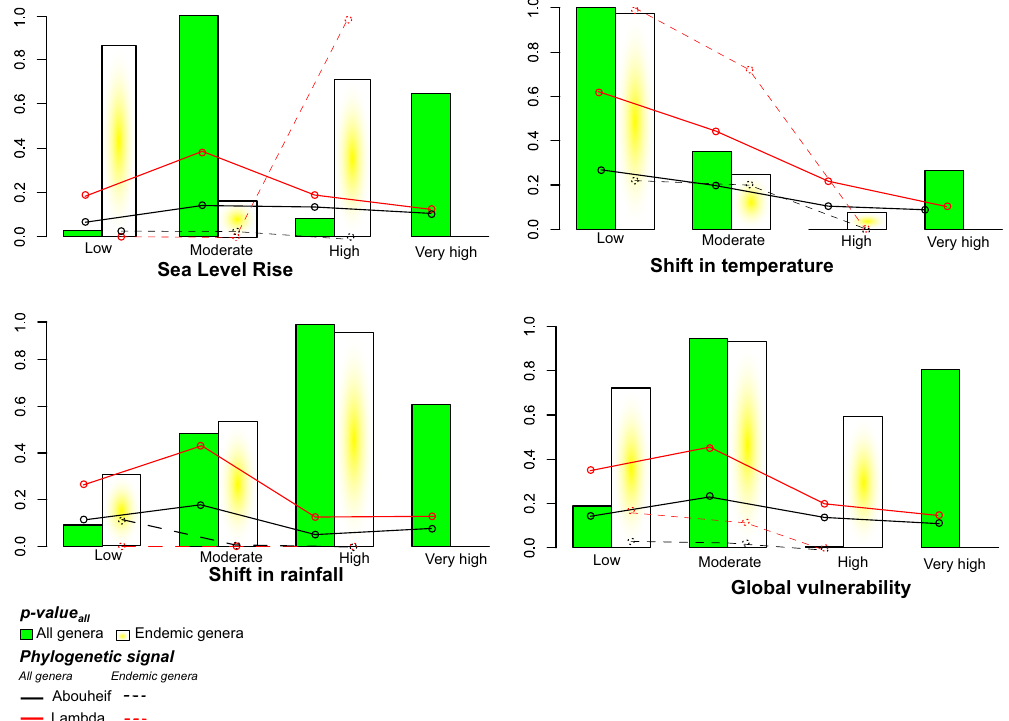
Figure 6. P_value all of the ExpPD loss for each vulnerability category and type of threat. Black and red curves represent the phylogenetic signal of extinction probabilities, calculated using Pagel’s λ and Abouheif’s statistical